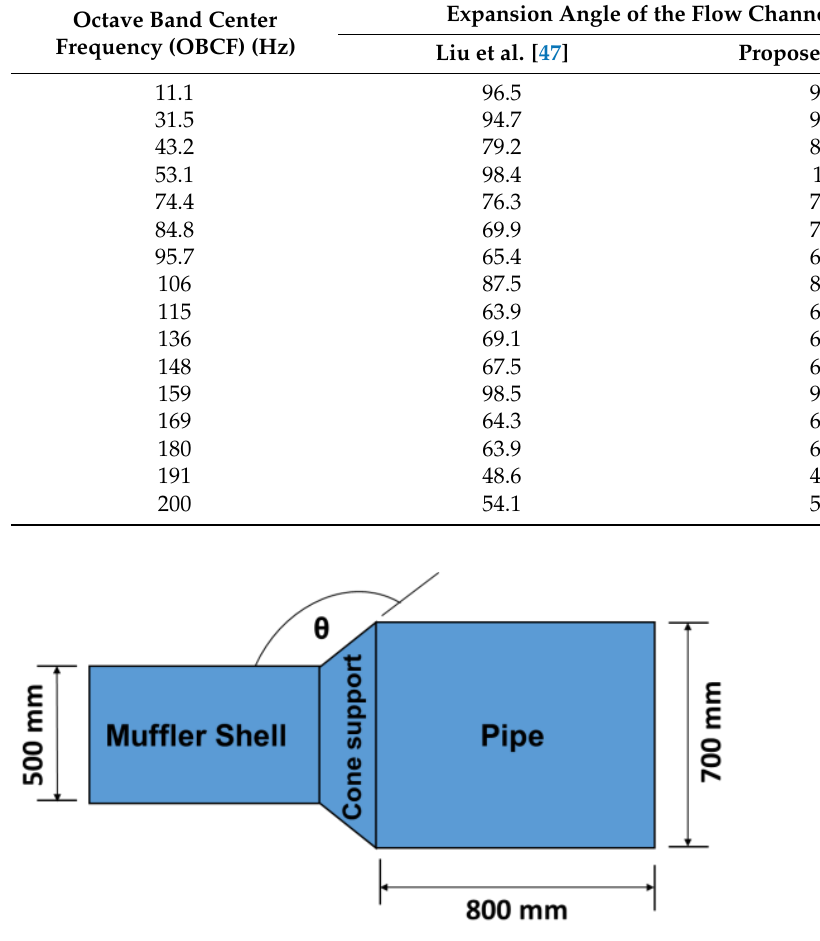
Figure 10. The flowchart of the ANN model framework.